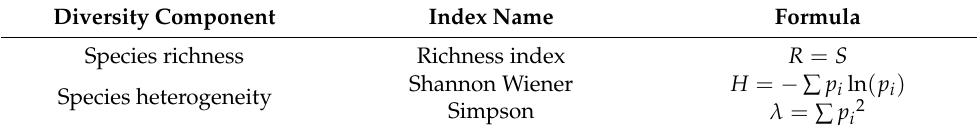
Table 2. Biodiversity indicators used in the study (Modified after Krebs